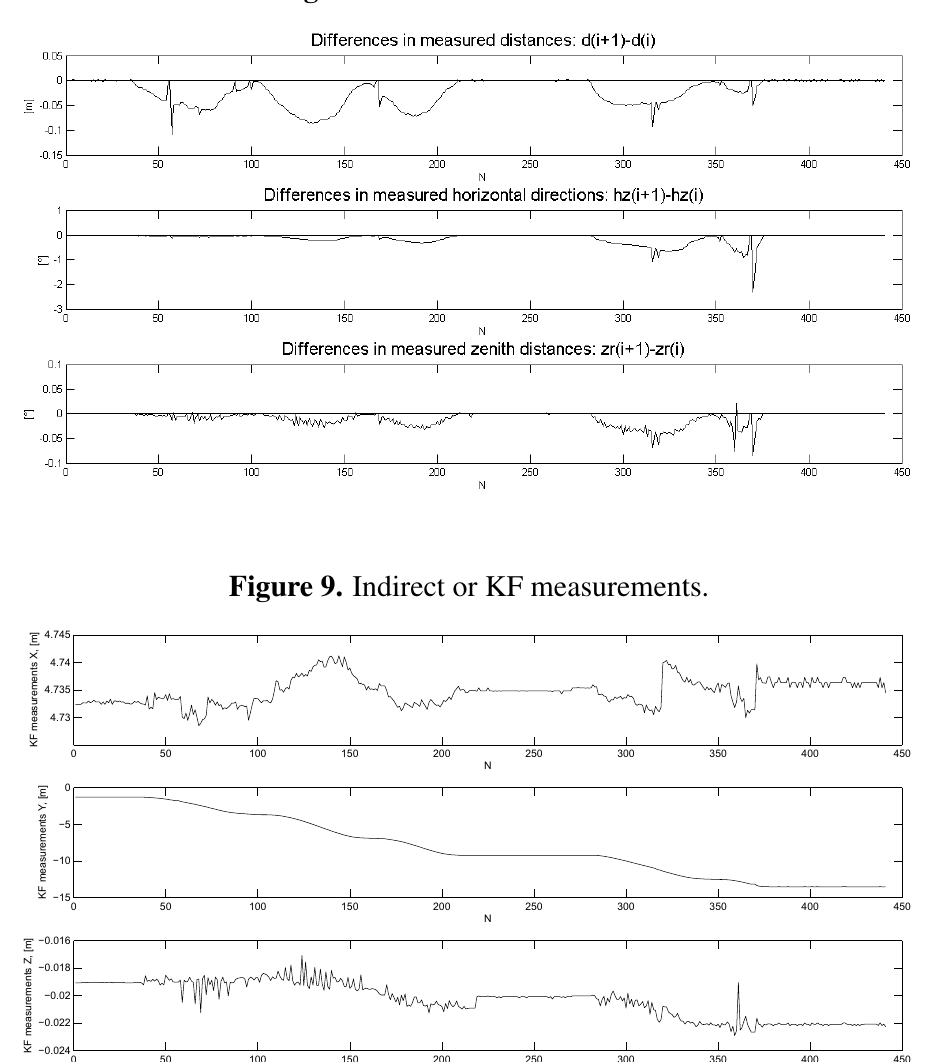
Figure 8. Direct measurements.